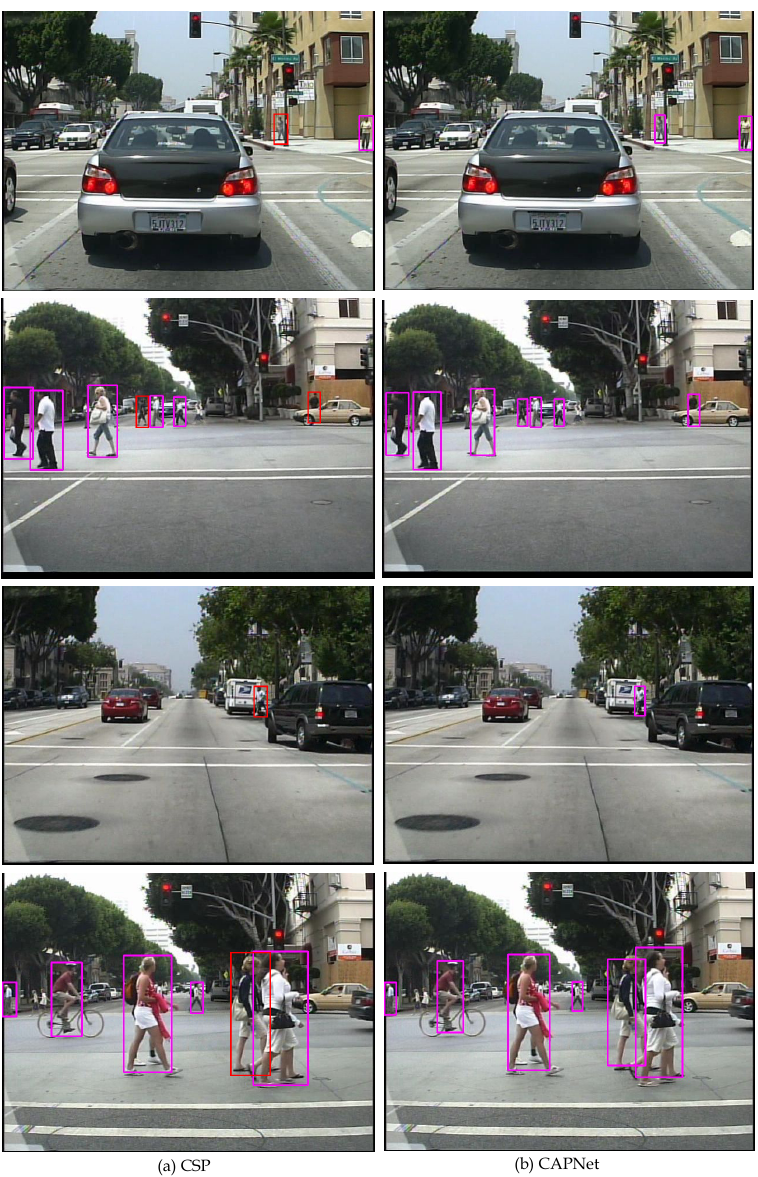
Figure 6. The detection results of the same five images in the test set on CSP and CAPNet. The area framed by pink boxes is detections output by the two detectors. The area framed by red boxes is pedestrians not detected by